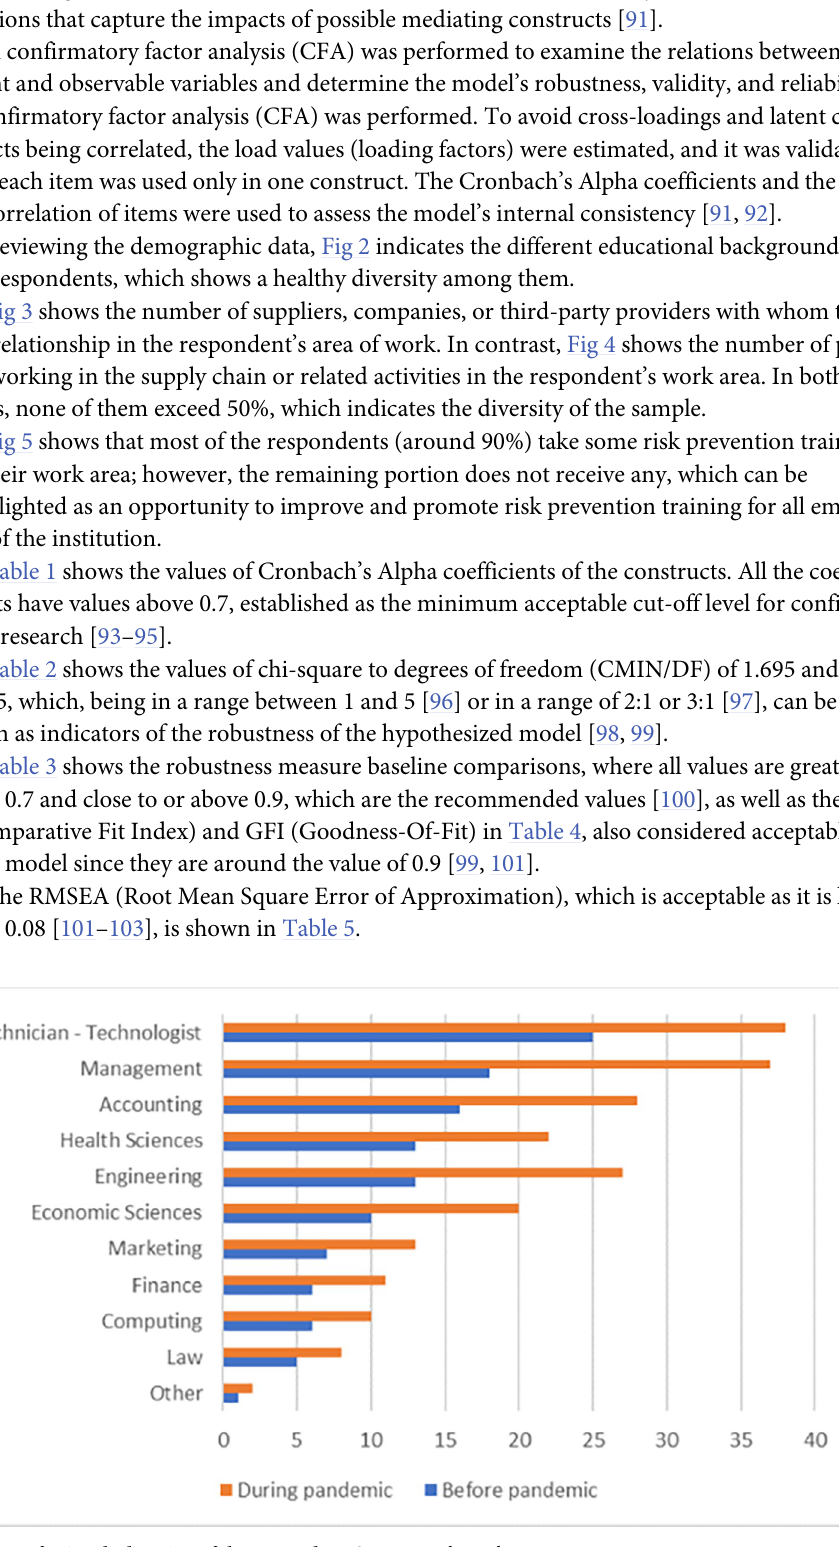
Fig 2. Professional education of the respondent. Source: By the